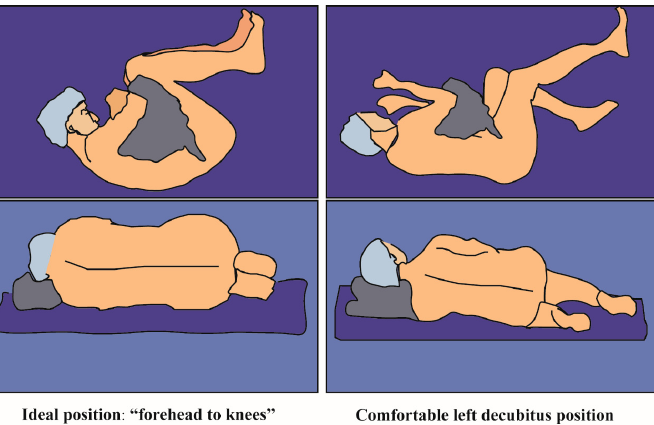
Figure 1. Patient’s position during the epidural catheter puncture. ( Left ): Ideal position (“forehead to knee”). ( Right ): Comfortable position (The patient wasn’t required to flex their thighs on their abdomen and flex their neck).